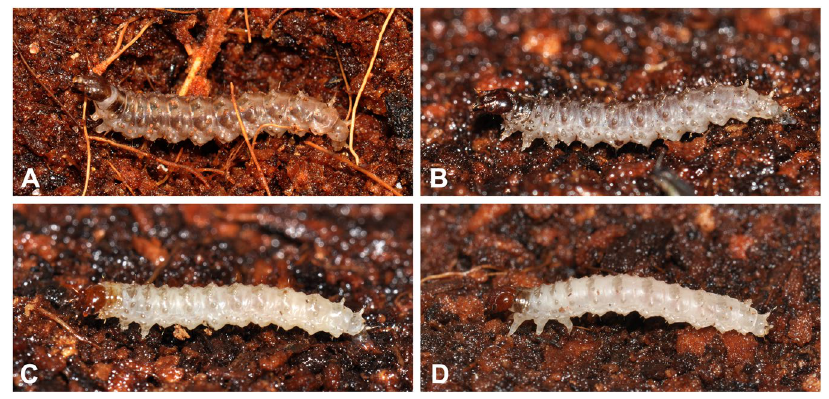
Figure 1. Larvae of Panorpidae in habitus. ( A ) Dicerapanorpa magna ; ( B ) Cerapanorpa nanwutaina ; ( C ) Panorpa curva ; ( D ) Neopanorpa lipingensis